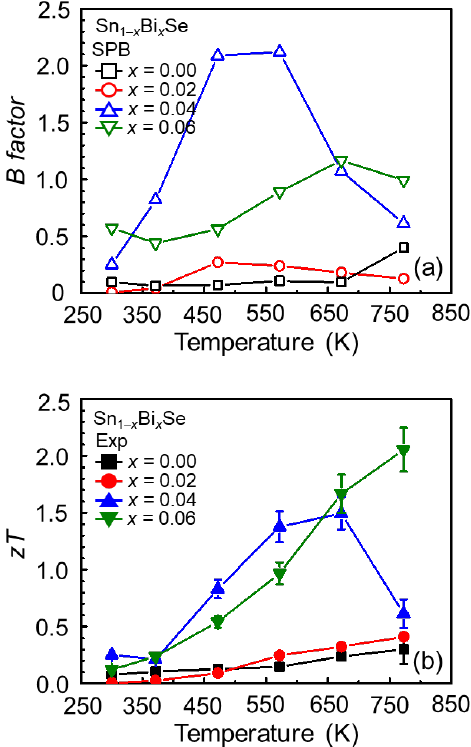
Figure 5. ( a ) Calculated temperature-dependent B- factor varying with x in Sn 1 − x Bi x Se ( x = 0.00, 0.02, 0.04, and 0.06), ( b ) experimental temperature-dependent zT varying with x in Sn 1 − x Bi x Se ( x = 0.00, 0.02, 0.04, and 0.06) [18].